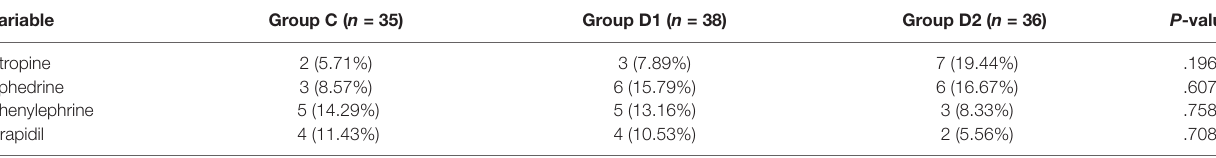
TABLE 3 | Consumption of vasoactive drugs during operation.